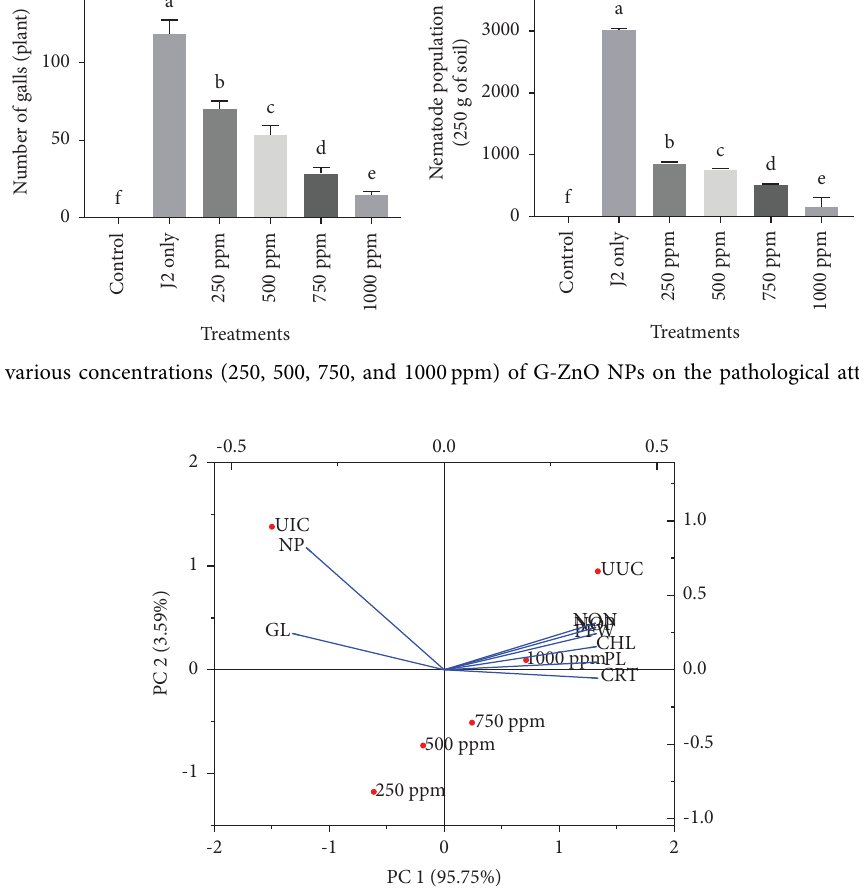
Figure 10: Te biplots of principal component analysis comparing the efect of various concentrations (250, 500, 750, and 1000ppm) of G- ZnO NPs on various studied parameters of chickpea infected with M. incognita . PL: plant length; PFW: plant fresh weight; NOP: number of pods; NON: number of nodules; CHL: chlorophyll content; CRT: carotenoid content; GL � gall per plant; NP: nematode population in the 200g soil